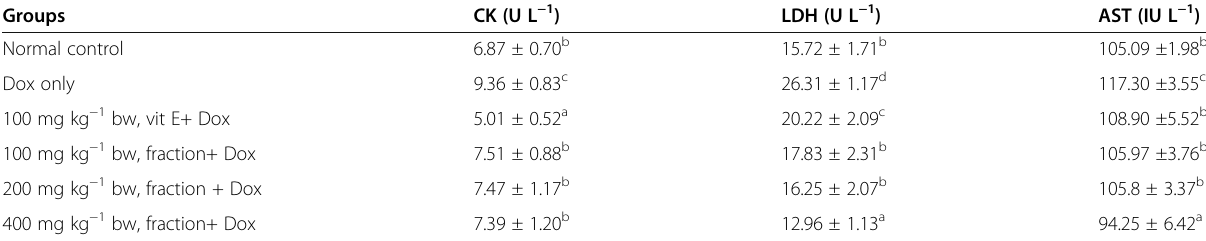
Results are expressed as mean ± SD. n = 5. Values in the same column having different superscripts differ significantly ( p <0.05) CK creatine kinase, LDH lactate dehydrogenase, AST aspartate